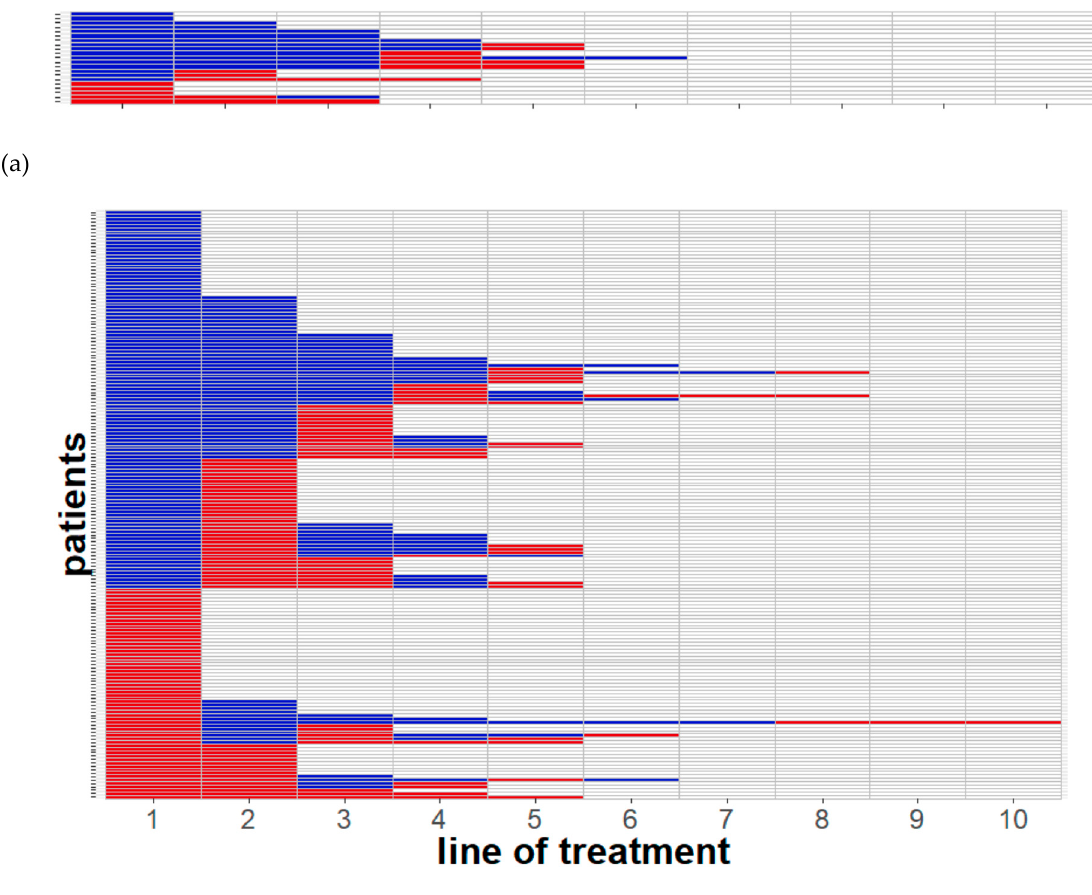
Figure 1. Heatmaps clustered by sequential therapy benefit showing a lack of cross-resistance among targeted therapies in mRCC (stratified by the International Metastatic Renal Cell Carcinoma Database Consortium (IMDC) prognostic risk score). Individual patients could still derive a clinical benefit despite failure in a previous line of therapy. ( a ) Favorable-risk prognosis treatment courses (21 patients); ( b ) intermediate- and poor-risk prognosis treatment courses (173 patients). Each row illustrates a single patient’s treatment course through a sequence of red and blue boxes from left to right. Each box shows one line of treatment (box size independent of therapy duration). Colors indicate therapy benefit (blue), lack of clinical benefit (red), or no further lines of treatment (gray) (for definitions, see “Materials and Methods”).